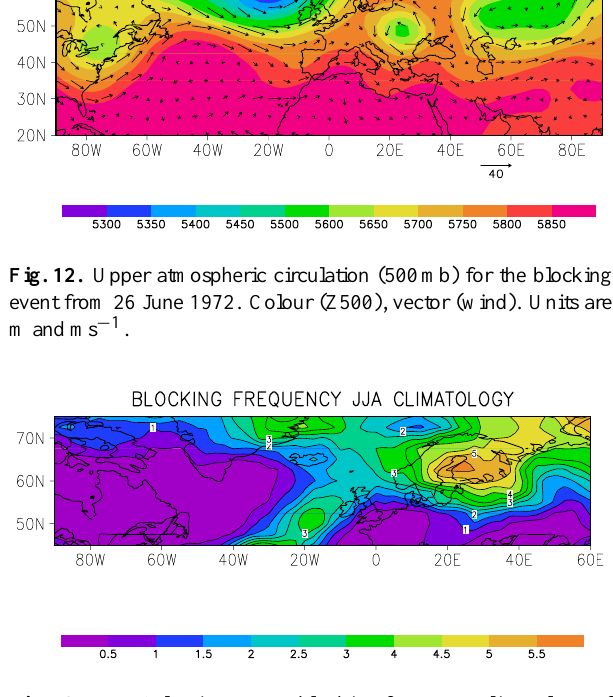
Fig. 13. Euro-Atlantic summer blocking frequency climatology of 5-day persistent blocking using the Scherrer et al. (2006) blocking indicator. Units are percentage of blocked days to total number of days per summer. Period is 1908–2005.